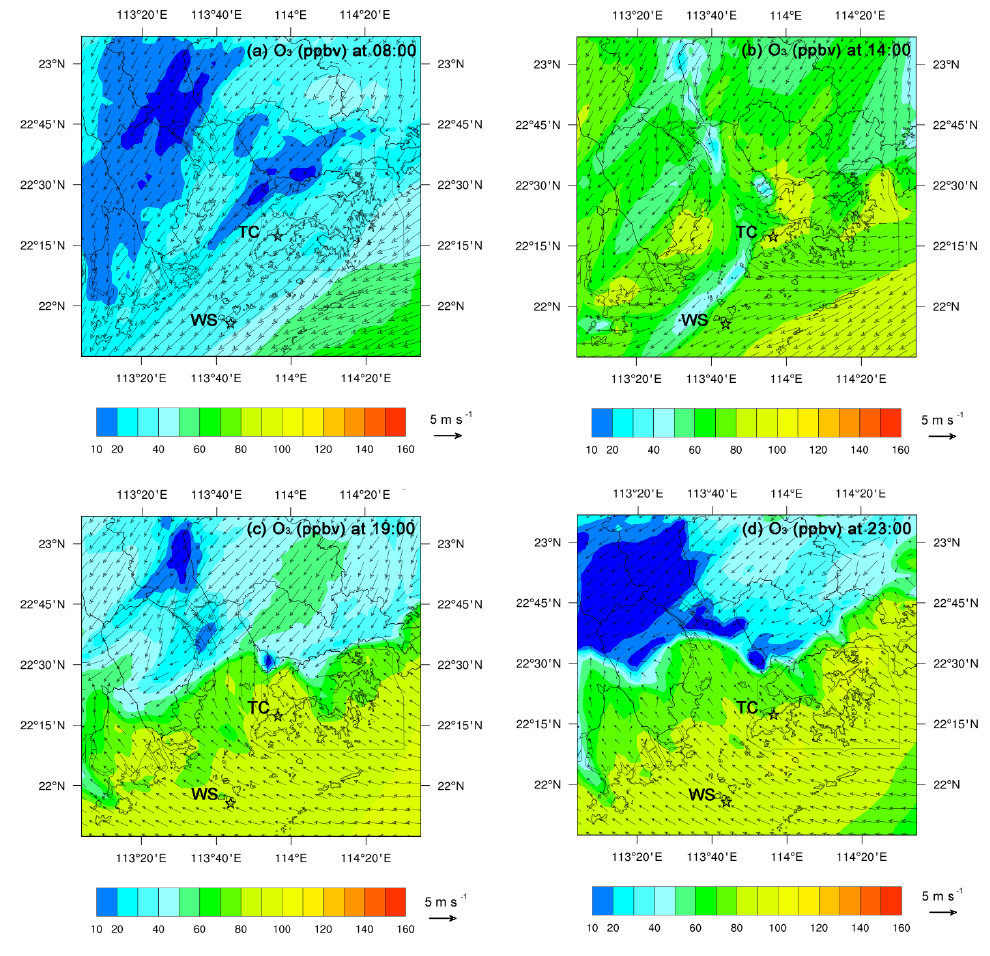
Figure 8. Spatial distribution of O 3 at 08:00 (a) , 14:00 (b) , 19:00 (c) and 23:00 (d) on 3 October, taken as an example of the sea–land breeze interaction pattern. Arrows in the figure represent the surface wind